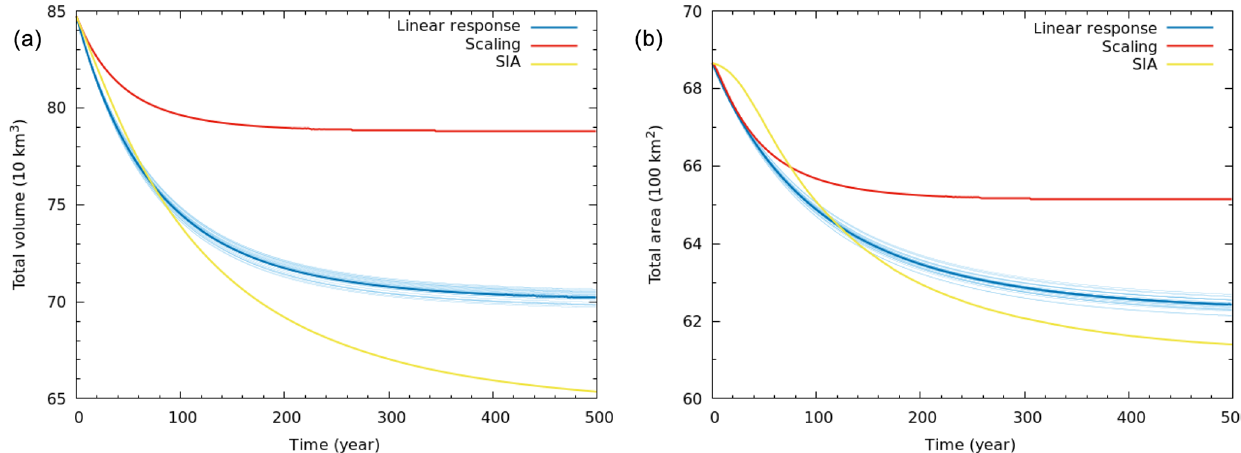
Figure 4. The evolution of the total (a) volume and (b) area of the ensemble of 703 Himalayan glaciers simulated with three different methods: SIA, scaling, and linear-response models. The uncertainty bands for the linear-response model results are also shown. See text for